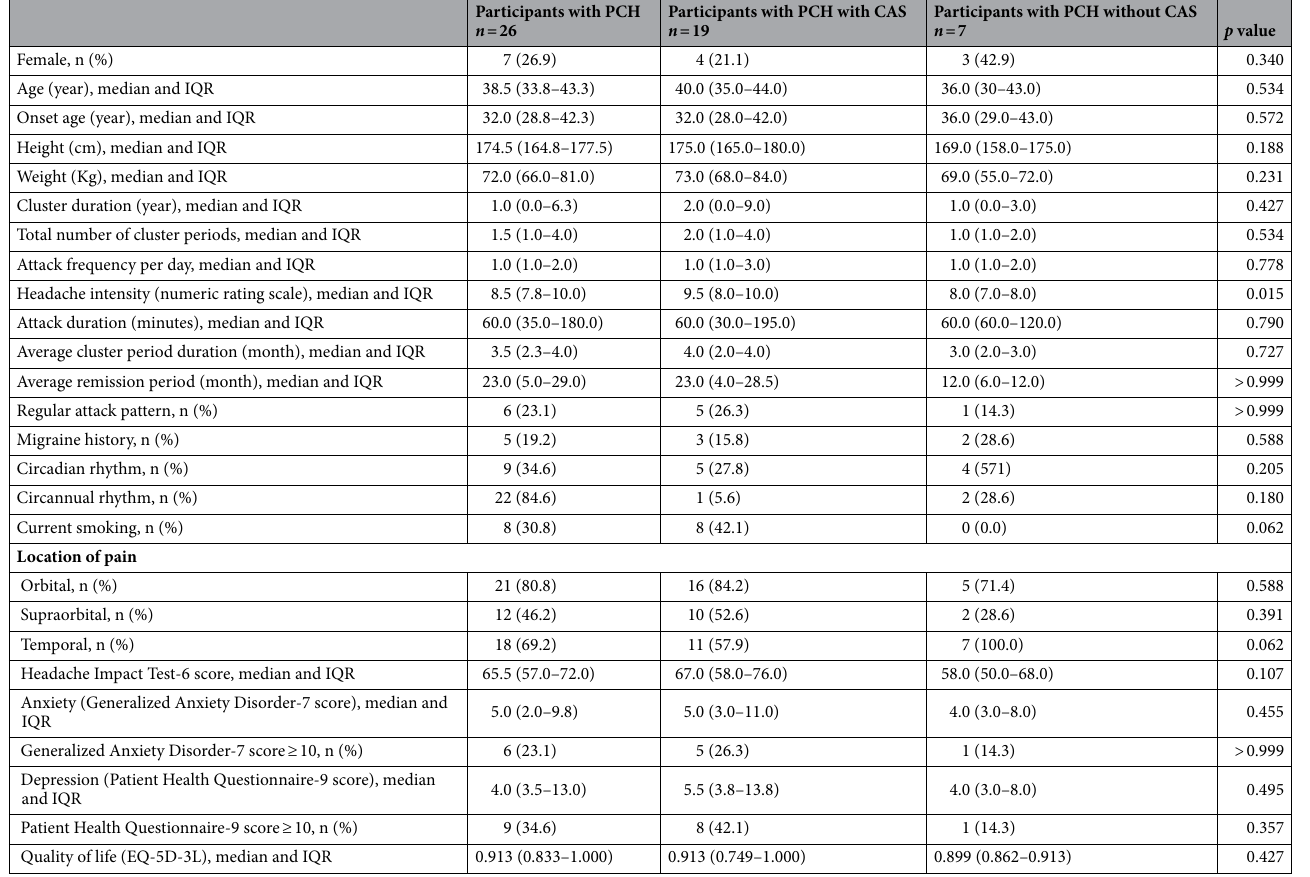
Table 5. Clinical features of participants with PCH according to the presence of CAS. CAS cranial autonomic symptoms, EQ-5D-3L the 3-level version of EuroQol five-dimension scale, PCH probable cluster headache, IQR interquartile